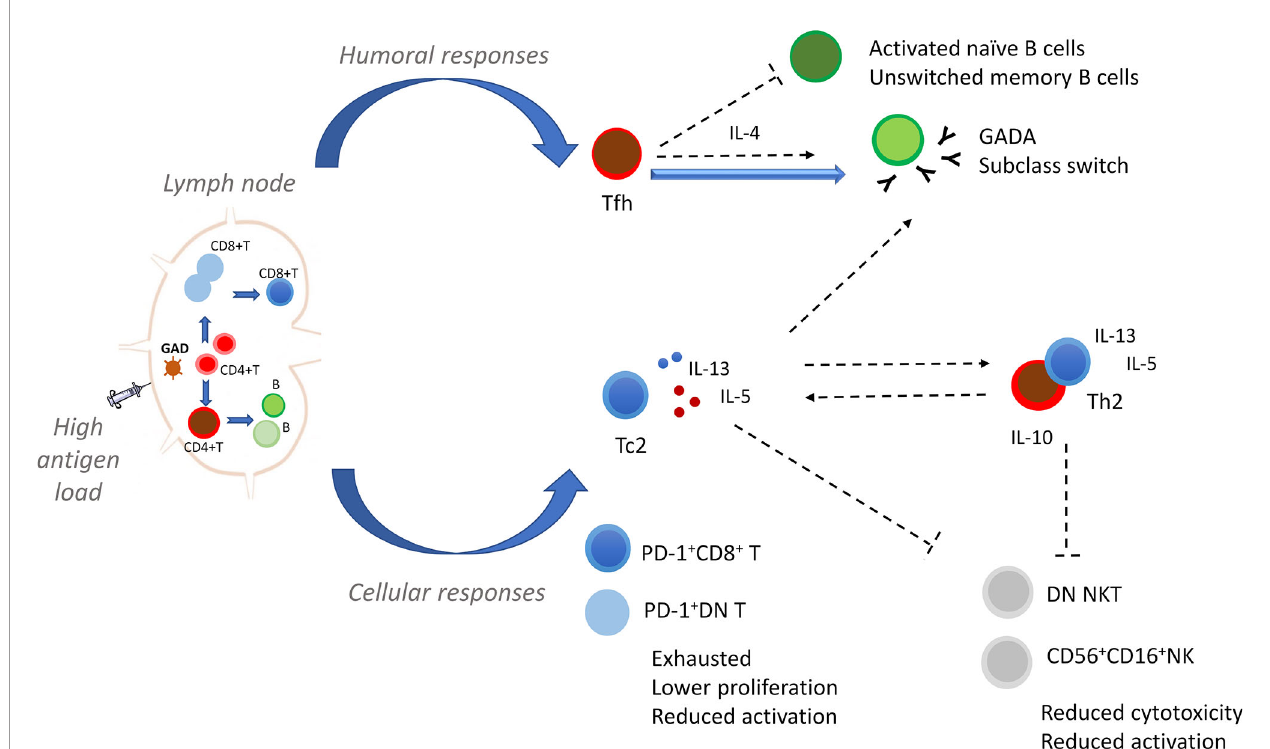
FIGURE 1 | Proposed immunomodulatory effect of GAD-alum injections into the lymph node. Our hypothesis is that the quality of GAD-speci fi c immune responses is determined by direct administration of GAD-alum into the lymph node. Delivery of high antigen dose into the lymph node stimulates antigen-speci fi c T and B cells in GADA positive individuals, and the use of alum, an adjuvant associated with Th2 responses, leads to induction of GAD-speci fi c humoral and cellular immunity, and reinforcement of Th2 immune responses. Immunomodulation of the cellular immune response results in the expansion of CD8+ and double negative (DN) T cells expressing PD-1. We propose that the expansion of these cells may be related to reduced activation of CD8+ T cells and decreased proliferation upon GAD 65 stimulation. Likewise, the regulation of the humoral immunity given by the feedback loop between follicular helper T cells (Tfh) and B cells is also determined by the high antigen level available for priming CD4+ T cells. Induction of Tfh cells supports their role in the activation and maturation of B cells leading to an increase in GADA titers and shift of GADA subclasses following GAD-alum injections. The Tfh: B interactions may also result in the reduction of activated naïve and unswitched memory B cells. Generation and establishment of a predominant Th2 responses to GAD 65 might counteract pro-in fl ammatory factors and generate an environment where Tc2 CD8+ T cells are expanded and further produce IL-5 and IL-13. Restoration of the immunological balance leads to suppression of autoreactive immune responses and reduction of Th1 effector cells, DN NKT and NK cells. Dashed lines indicate possible